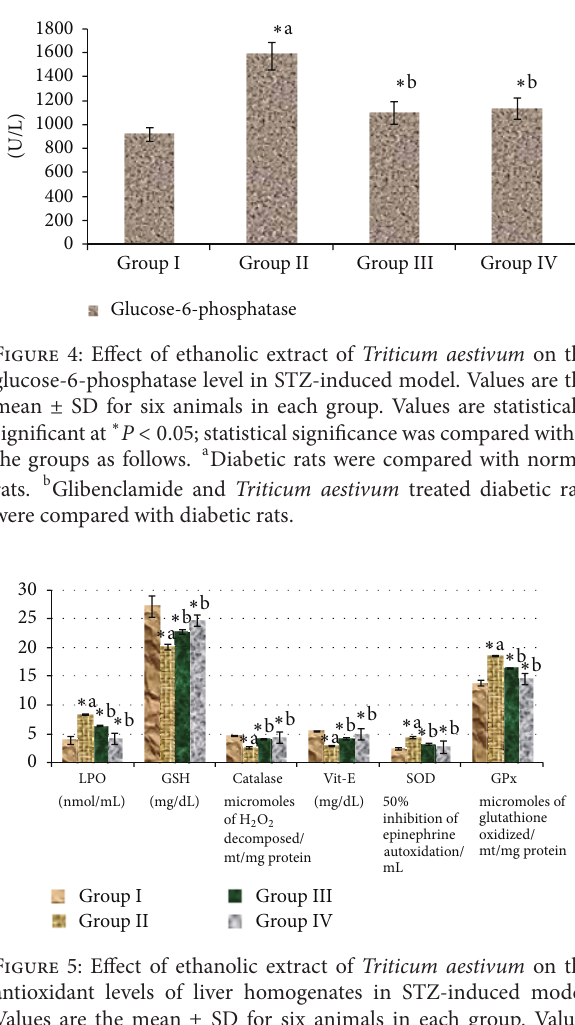
Figure 3: Effect of ethanolic extract of Triticum aestivum on the hexokinase and LDH levels in STZ-induced model. Values are the mean ± SD for six animals in each group. Values are statistically significant at ∗ P < 0.05; statistical significance was compared within the groups as follows. a Diabetic rats were compared with normal rats. b Glibenclamide and Triticum aestivum treated diabetic rats were compared with diabetic rats.